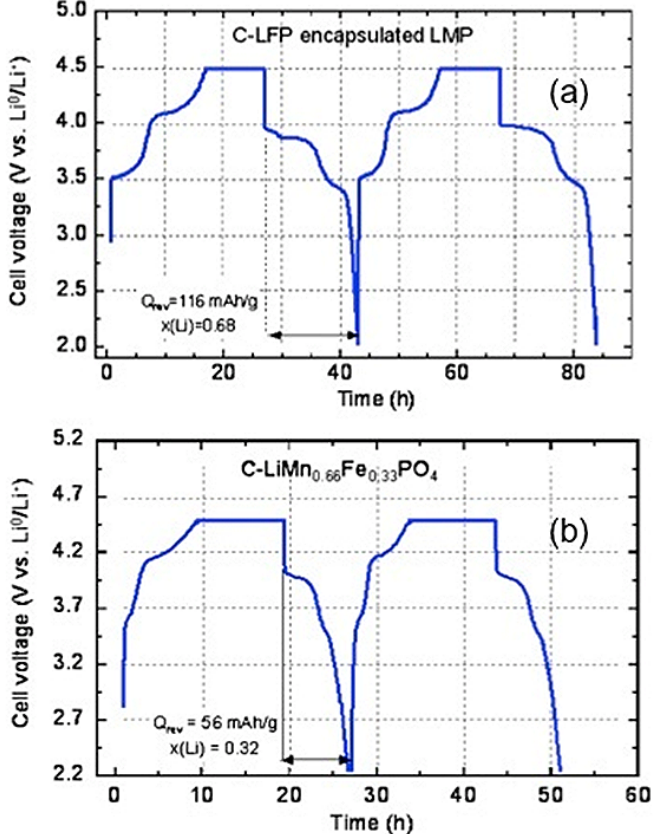
Figure 5. Voltage as a function of time in charge/discharge conditions corresponding to theoretical rate C/24 for the composite C-LiFePO comparison. (Reprinted with permission from [59]. Copyright 2012